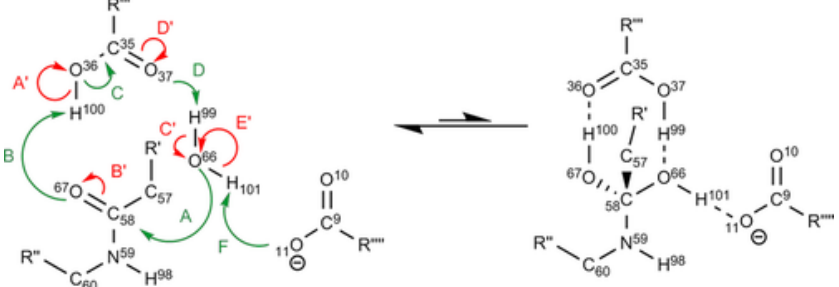
Figure 5. Diagram representing the changes in the strength of the different bonds. The greens arrows represent bond strengthening/forming and while the red ones bond weakening/breaking. Figure taken from Reference